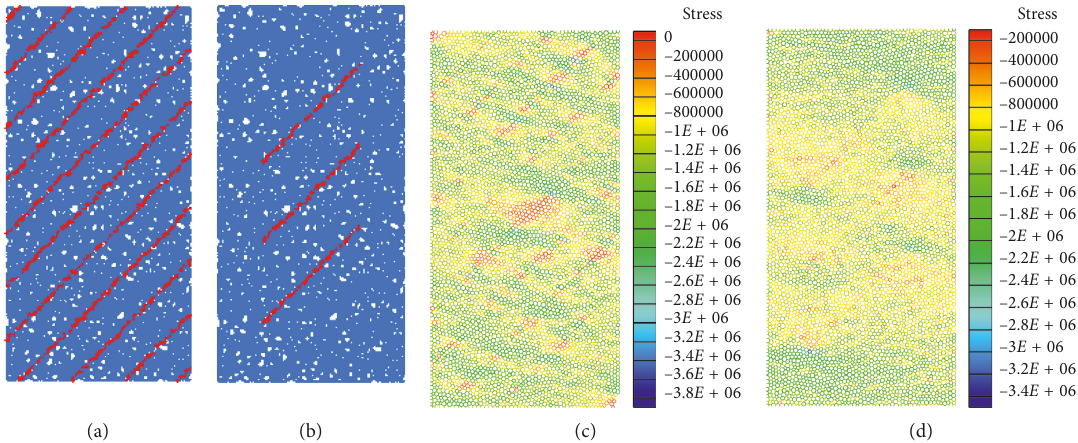
Figure 8: Schematic of joints and initial stress distribution. (Red lines indicate joints. The specimens have a width of 50mm and a height of 100mm. The initial confining stress is 1 MPa.) (a) Persistent joints; (b) nonpersistent joints; (c) initial stress distribution for the persistent joints; (d) initial stress distribution for the nonpersistent